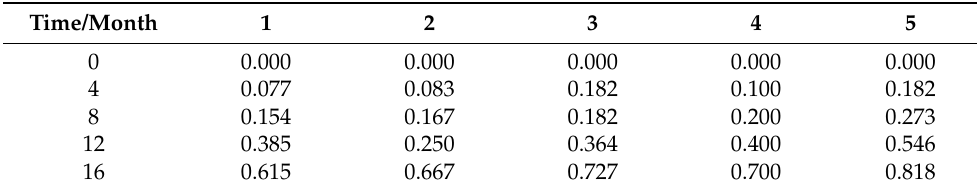
Table 3. Degradation data of momentum wheel current.